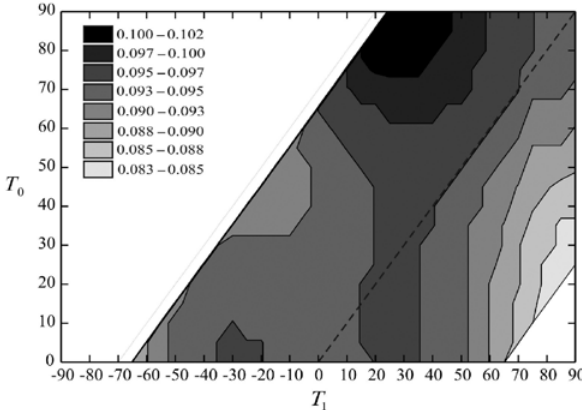
Figure 6: Contour plot of Ω for the clamped boron/epoxy [  〈 T circular laminate.